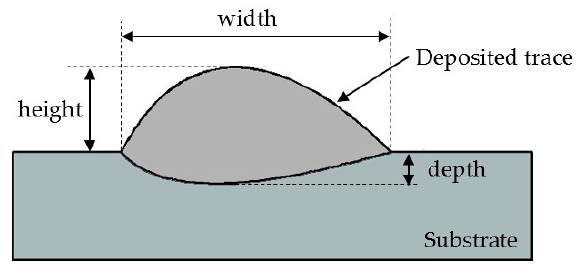
Figure 5. Scheme of the deposited trace cross-section geometrical parameters.